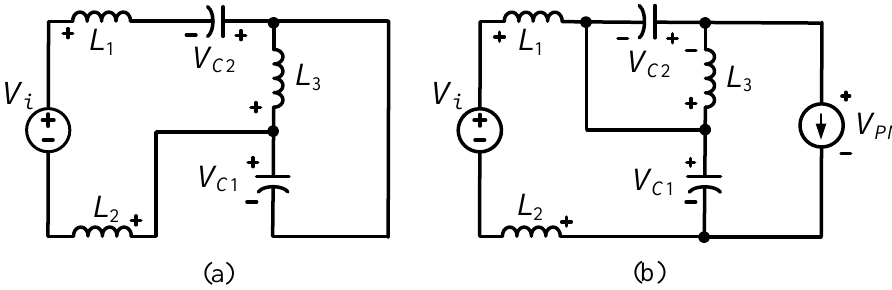
Figure 4. Equivalent circuit of MAqZSI. ( a ) Shoot-through mode, ( b ) Non-shoot-through mode.